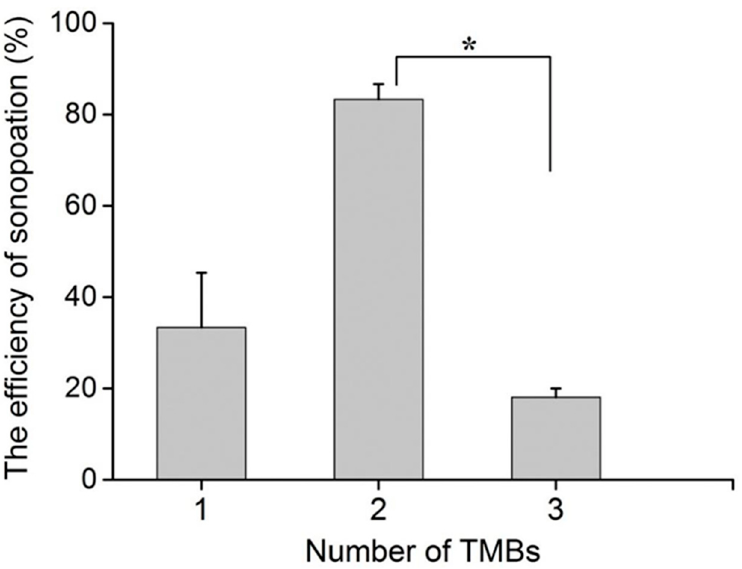
Figure 8. The impact of TMB number on cell sonoporation. When the ultrasonic input voltage was 350 mVpp, the cell sonoporation efficiency was significantly different for the two TMBs bounded to the cell membrane, compared to the other groups. * p < 0.05 and 10 cells were used for each group across the three experiments.